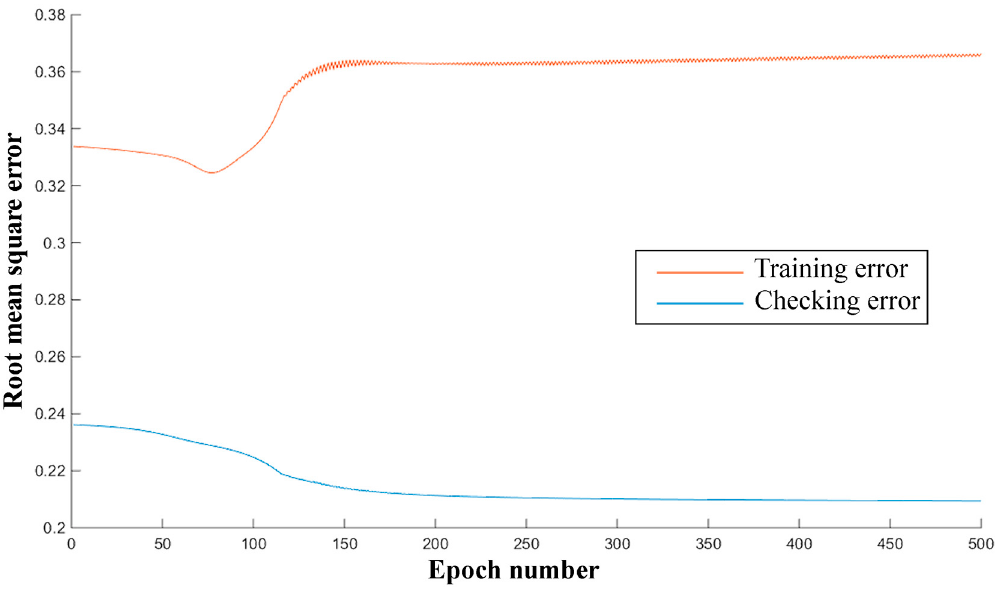
Figure A1. Indentification of optimum epoch number based on the root-mean-square error of both training error and checking error.